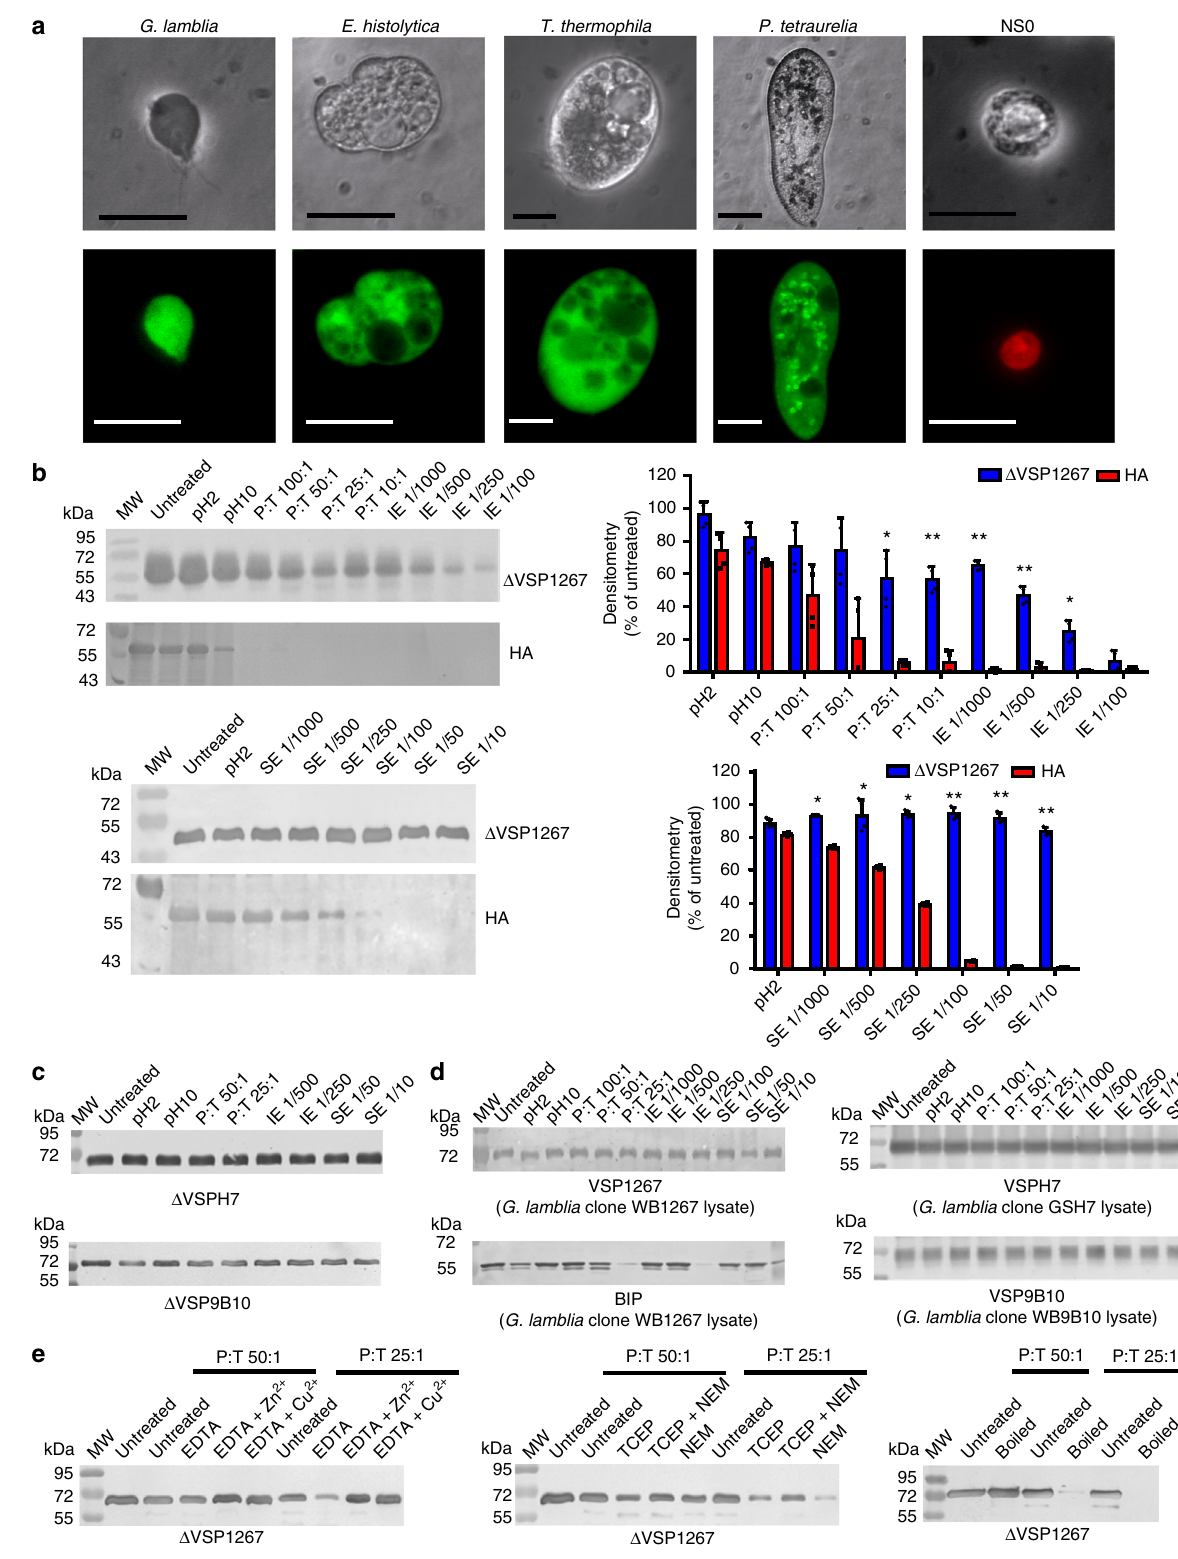
Δ VSP9B10 and Δ VSPH7 also showed a strong and dose- dependent activation of TLR-4. Conversely, recombinant HA expressed and puri fi ed using the same approach did not show activation of any of these receptors (Fig. 2b). To rule out any contamination with LPS, which is a known agonist of